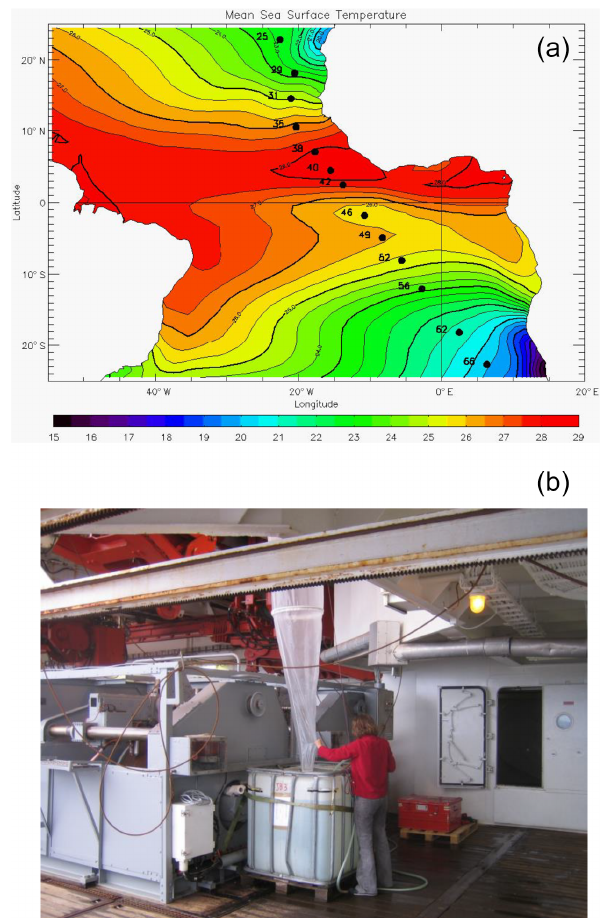
Figure 1. Stations used in this study plotted on gridded data set (Reynolds et al., 2002) (a) . Setup for planktonic foraminifera col- lections (b)